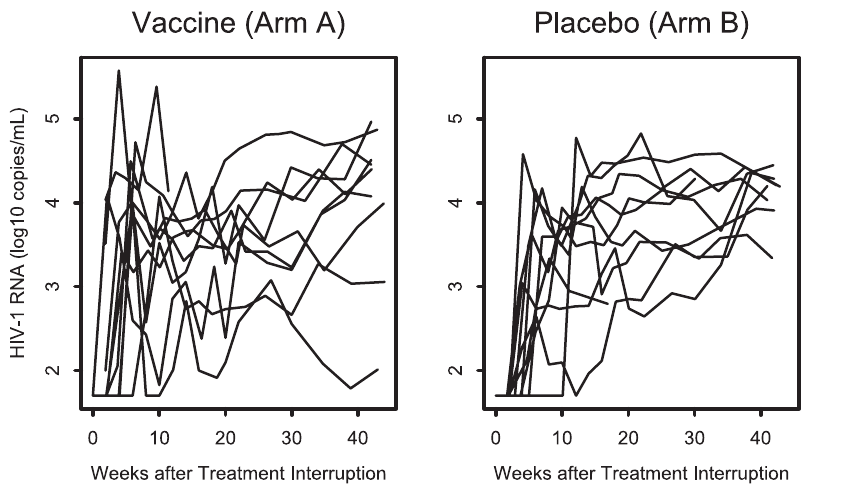
Figure 1. HIV-1 RNA levels following treatment interruption in Arm A (vaccine) and Arm B (placebo). The set-point viral load was determined by measuring HIV-1 RNA between weeks 17–23 of the treatment interruption. The median viral loads at setpoint were 3.5 and 3.7 log 10 copies/ml in Arms A and B, respectively.